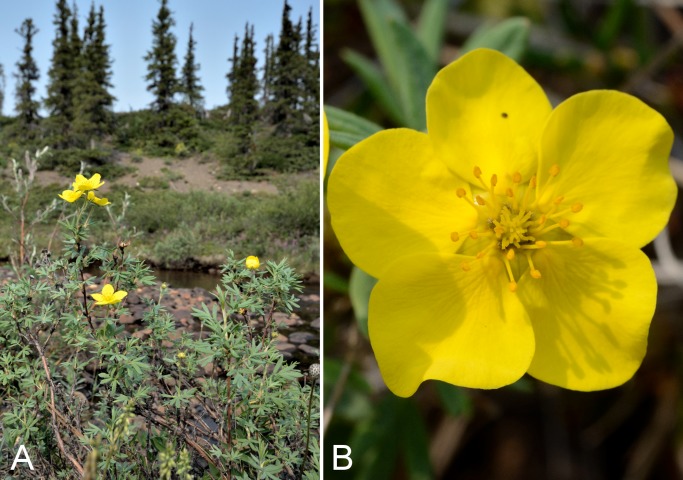
Dasiphora fruticosa.(A) Habitat, Saarela et al. 3123. (B) Inflorescence, Saarela et al. 3123. Photographs by R. D. Bull.